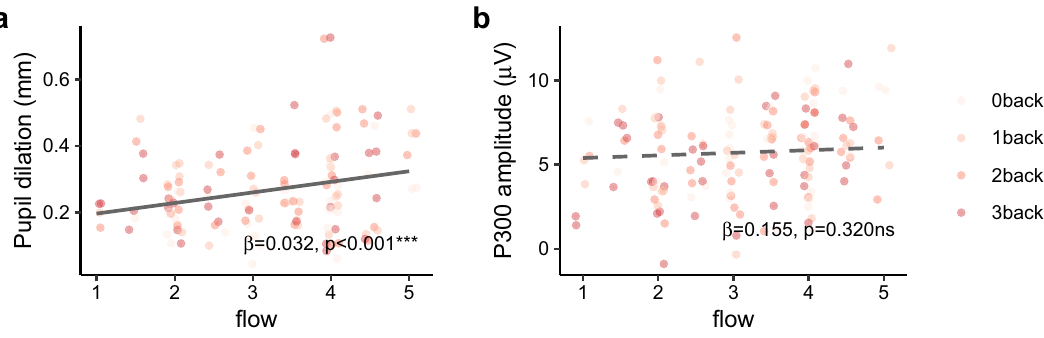
Figure 4. Correlations. ( a ) Linear relationship between pupil dilation and flow. ( b ) The relationship between P300 amplitude and flow failed to fit a linear